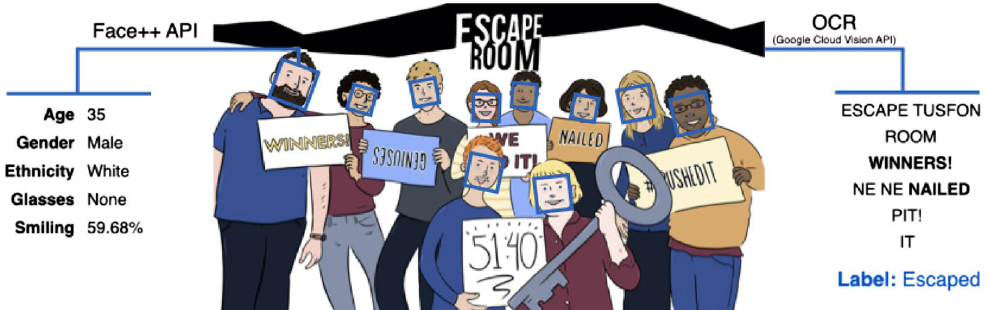
Figure 1. A sketch of a real photo of a group after playing Escape The Room. We used Face++ to locate and analyze the faces of the group members. The rectangles show the locations of the detected faces. The annotation on the left shows the features extracted for the group member on the far left. To determine whether the group escaped or not, we used OCR to extract the text on the signs that the participants hold (raw OCR output shown on the right of the photo) and checked for keywords that appear on winning or losing signs. In this example, two winning keywords were detected (in bold) and the photo was labeled as escaped. All data analysis and experiments presented in this paper were done on real photos. We use this illustration only to describe the